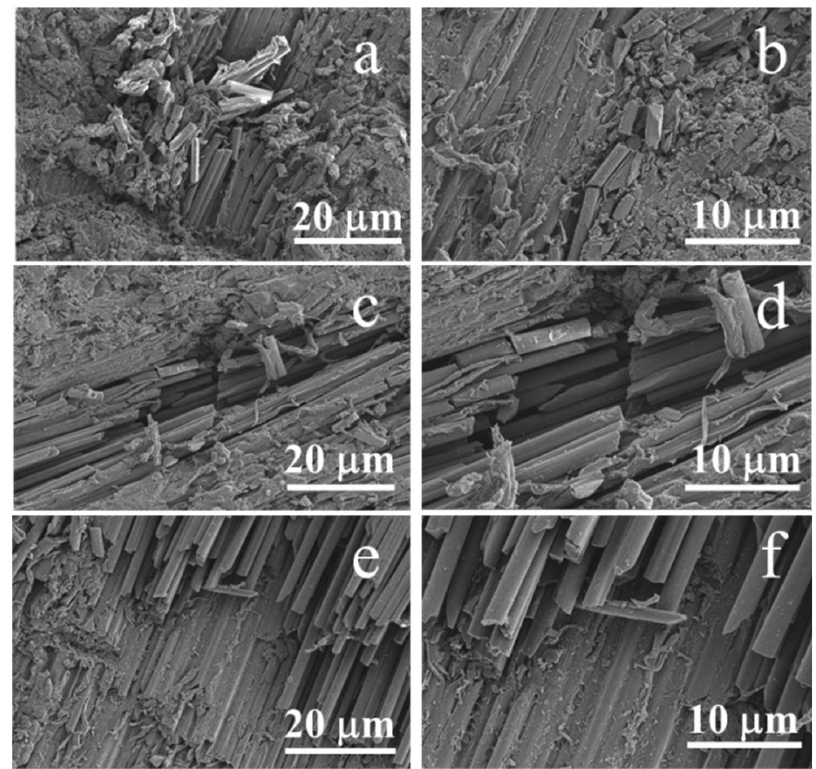
Figure 9. Surface topography of CF/PC composites after erosion. ( a , b ) un-aged composites surface after erosion at an angle of 30°,( c , d ) hydrothermal aged for 7 days composites surface after erosion at an angle of 30°, ( e , f ) hydrothermal aged for 42 days after erosion at an angle of 30° [29].